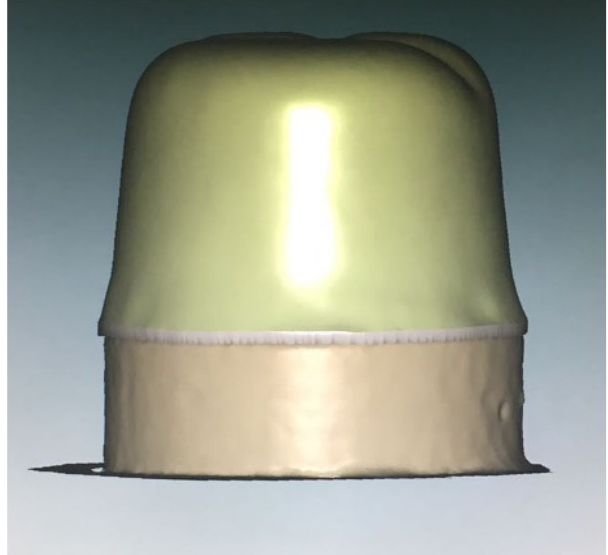
Figure 4. CAD Figure 4. CAD model.